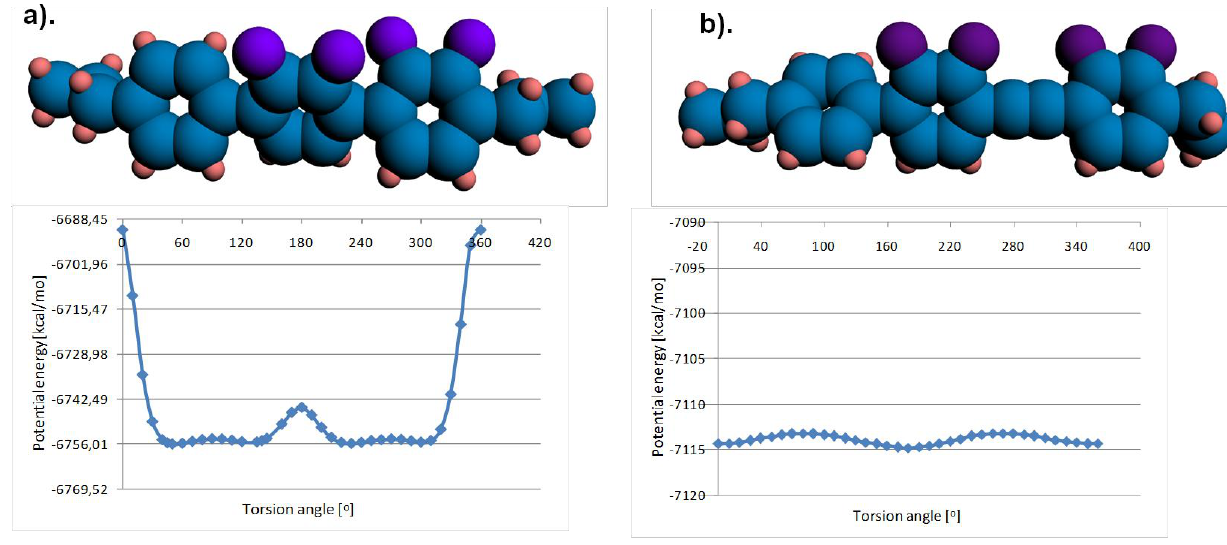
Figure 6. Change of potential energy of molecules upon twisting the angle between neighbor benzene rings in ( a ) 2,3,2′,3′-tetrafluoro-4,4′-dipropylterphenyl;